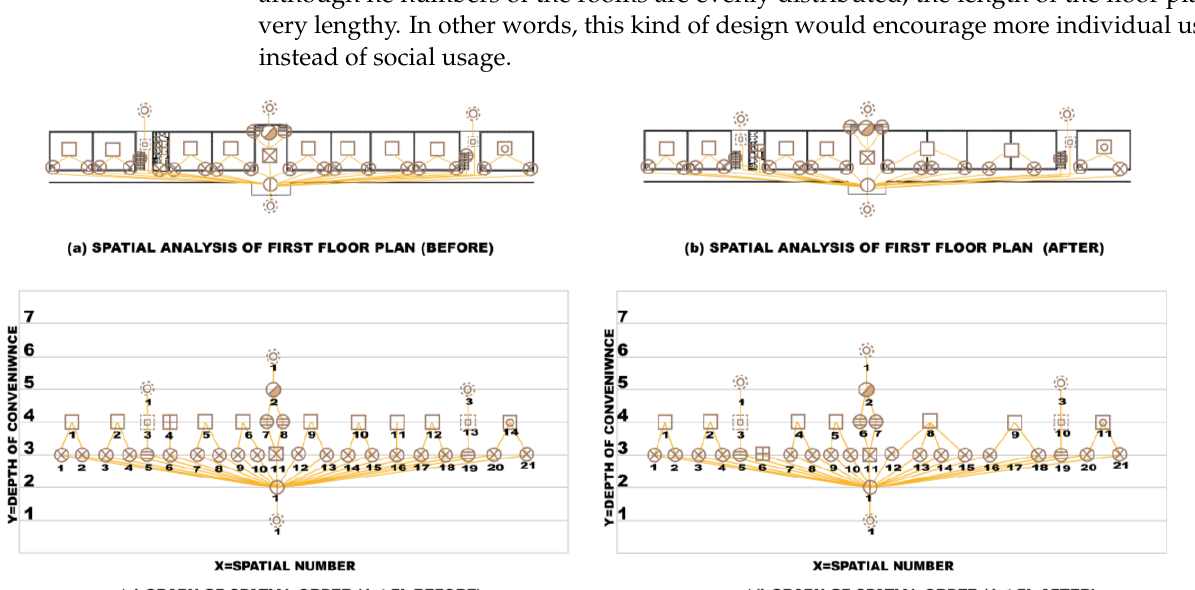
Figure 10. Past and Present’s Regeneration First Floor Plans of Nanhua Elementary School Space Relationship Diagrams. ( a ) Spatial Analysis (Before redesign). ( b ) Spatial Analysis (After redesign). ( c ) Spatial Order (Before redesign). ( d ) Spatial Order (After redesign).